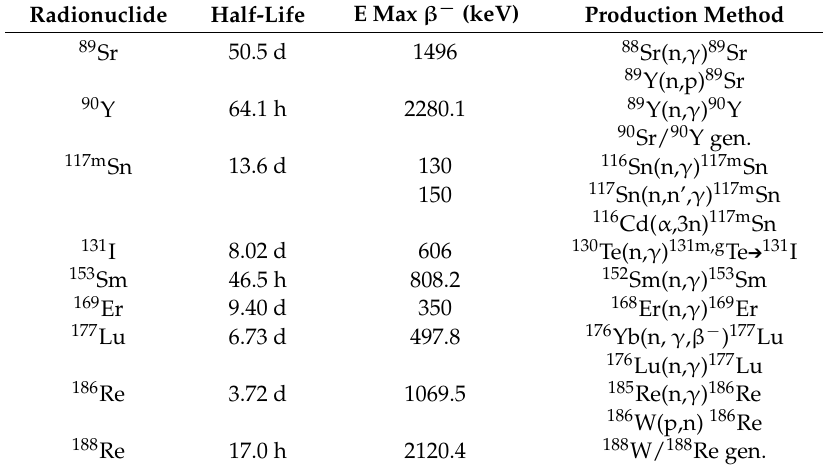
Table 1. Relevant physical characteristics of principal conventional therapeutic radionuclides [17–19].